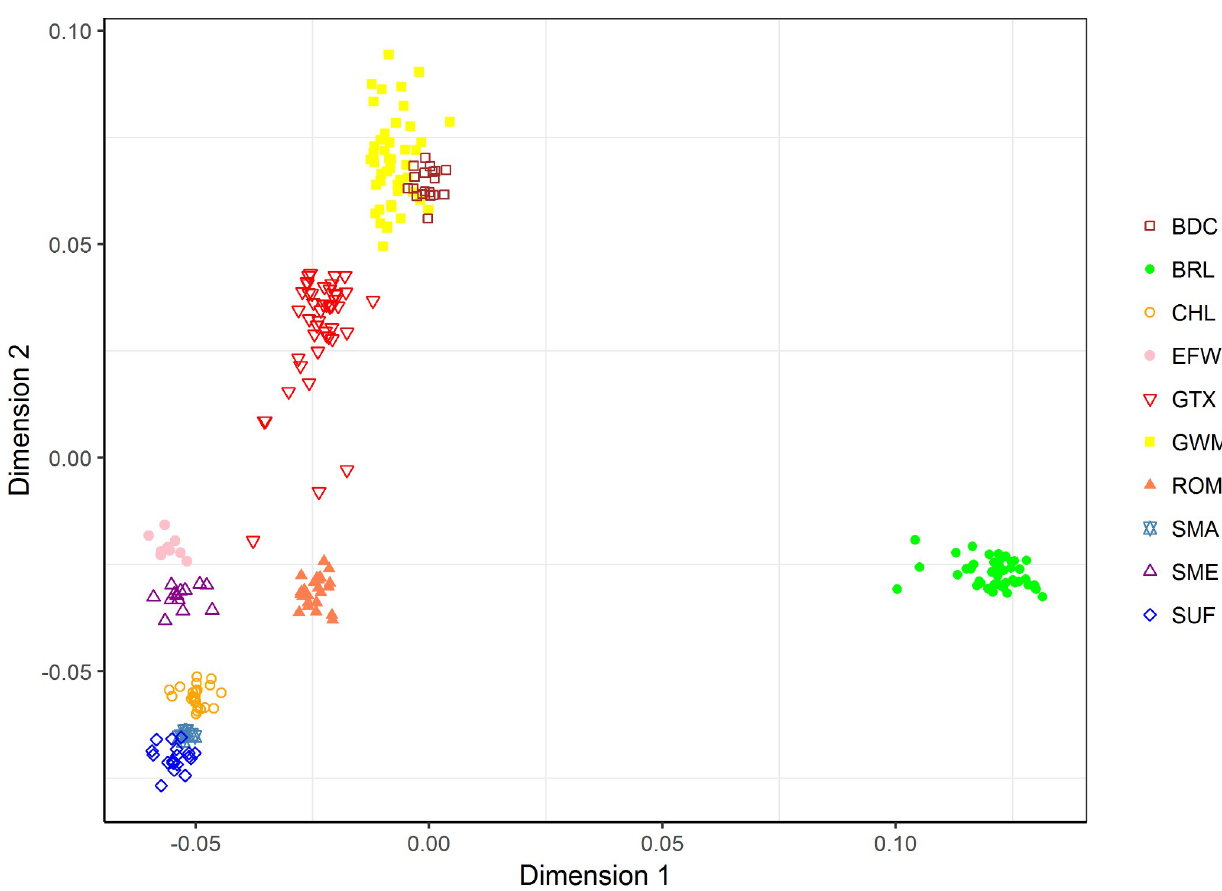
Fig 4. Multidimensional scaling plot of pairwise IBS distances among samples of 10 sheep breeds analysed based on 16,852 SNP markers (Data2). Breeds are distinguished by colour and shape.